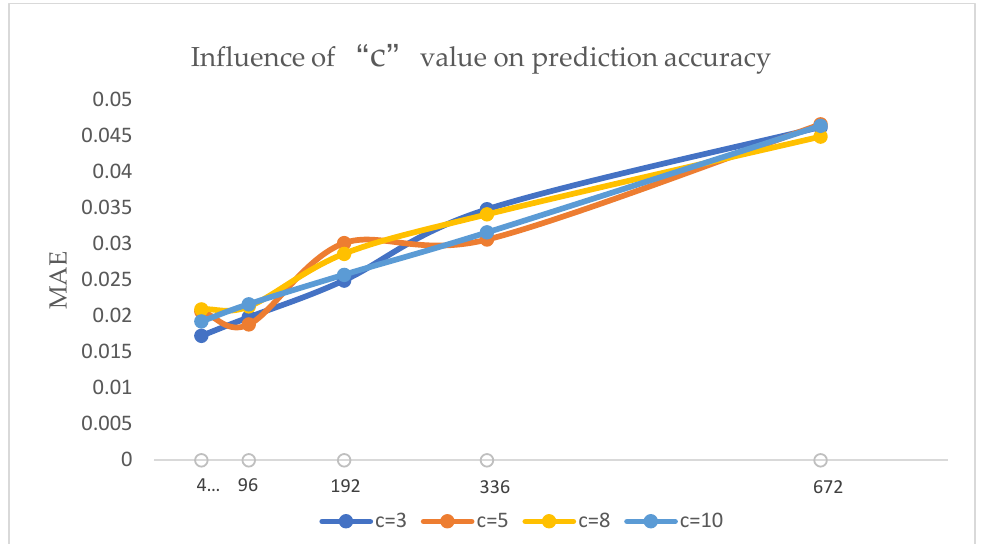
Figure 8. Prediction accuracy of Informer under different C values.